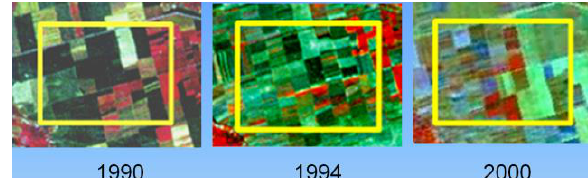
Figure 2. The dynamics of the agricultural landscape in the Romanian Plain